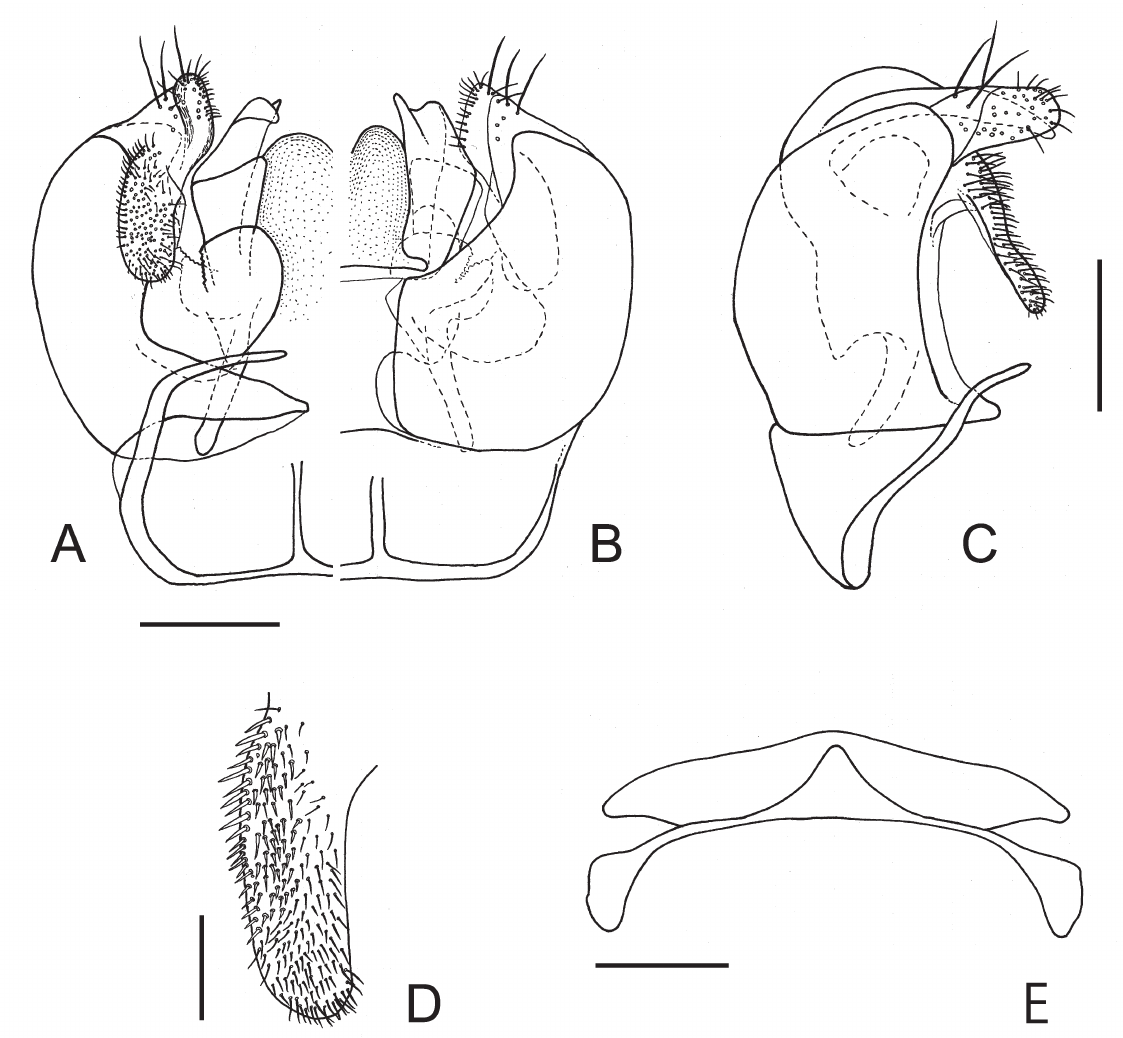
Fig. 7. Lasioglossum ( Dialictus ) atroglaucum (Strand, 1913), ♂. A . Genitalia in ventral view. B . Geni- talia in dorsal view. C . Genitalia in lateral view. D . Ventral retrorse lobe of genitalia. E . S7–S8. Scale bars: a–c, e = 0.2 mm, d =